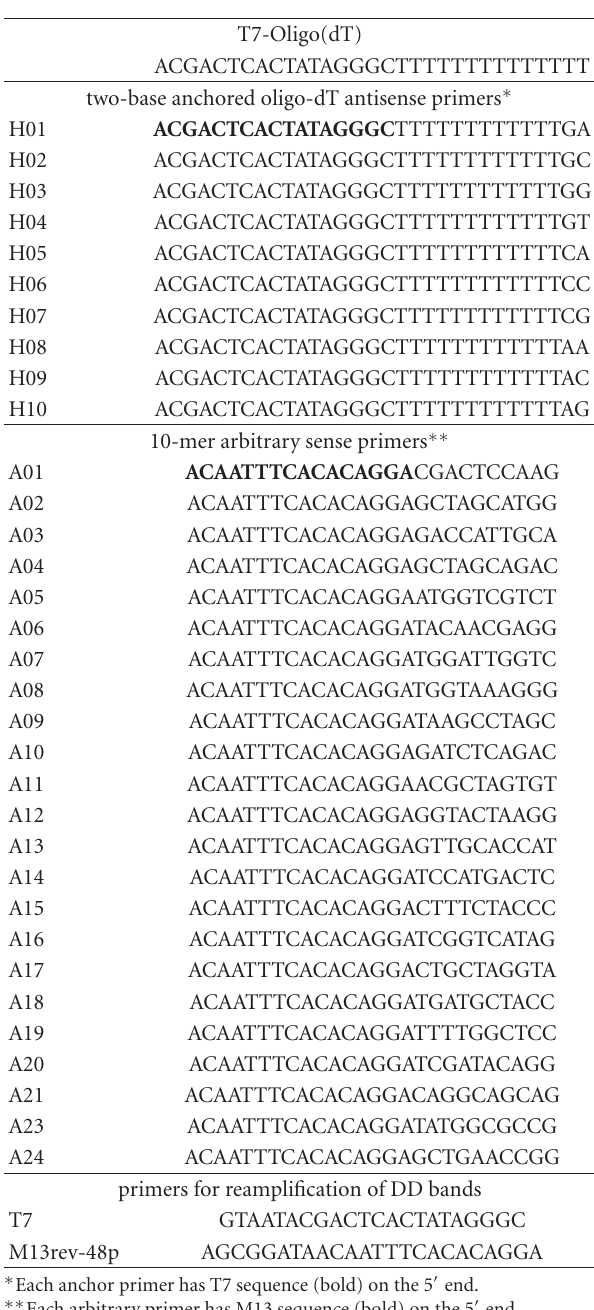
Table 1: Primers used in di ff erential display RT-PCR